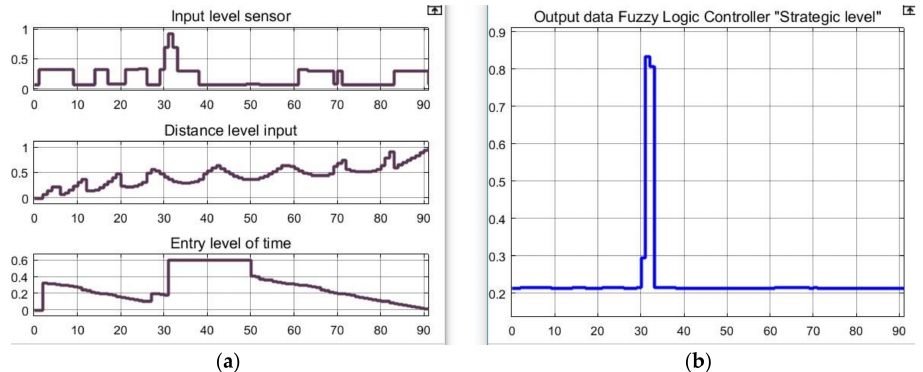
Figure 11. Graphics obtained from the Simulink model of the “Strategic level” control system. ( a ) Input values of sensors, distance and time; ( b ) Output value (box 31